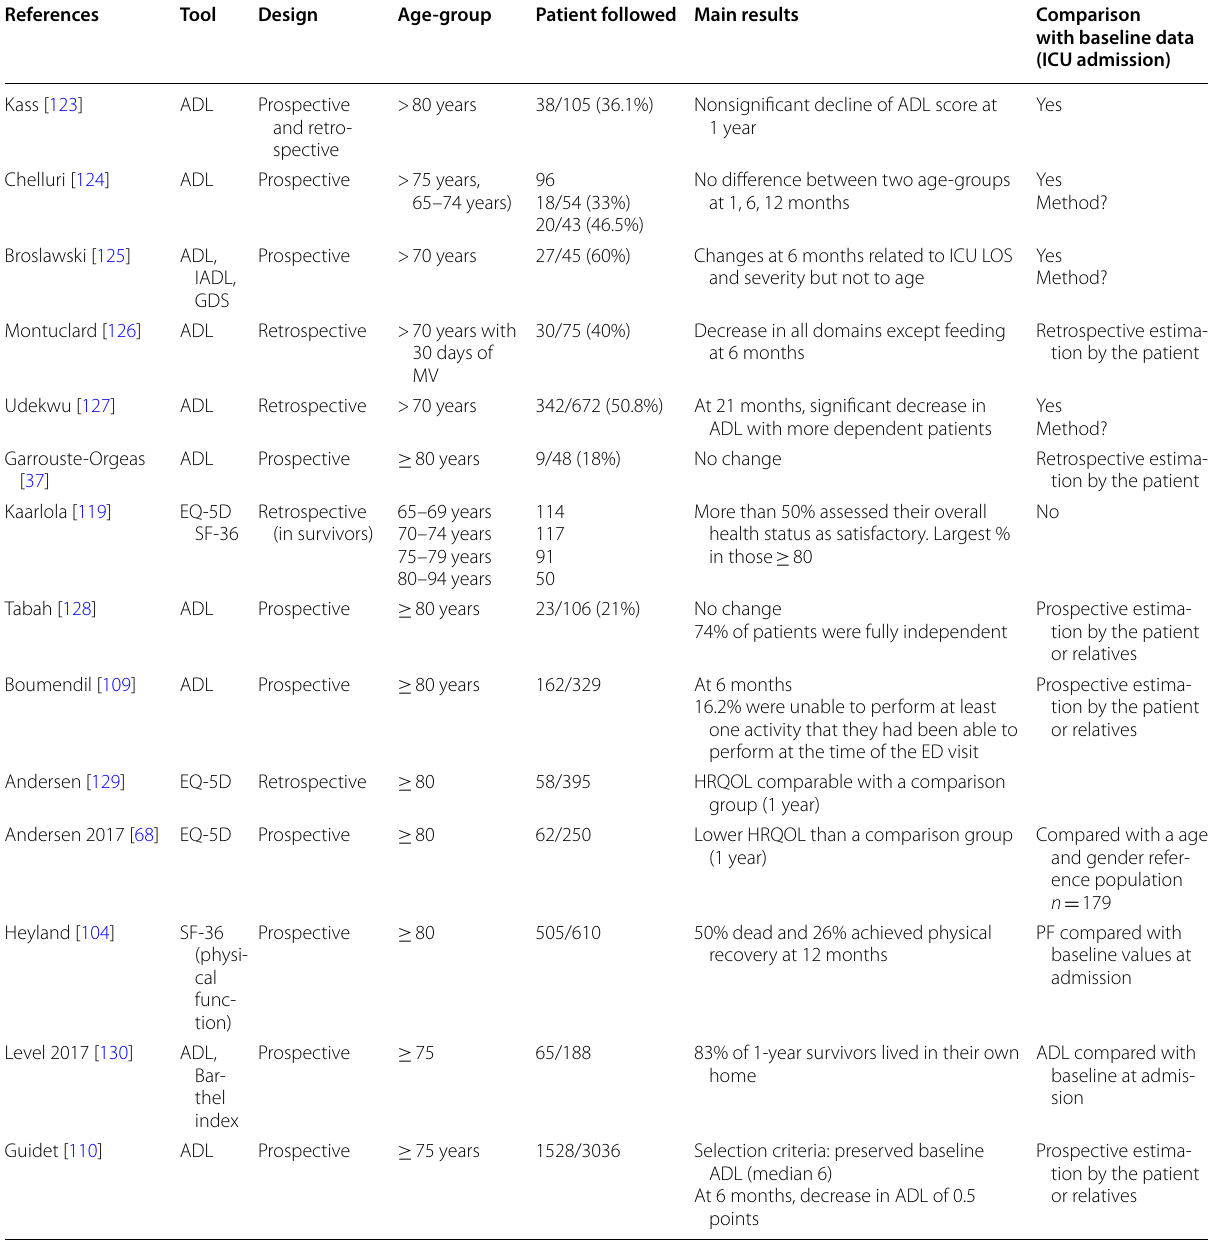
Table 3 Long‑term functional outcome